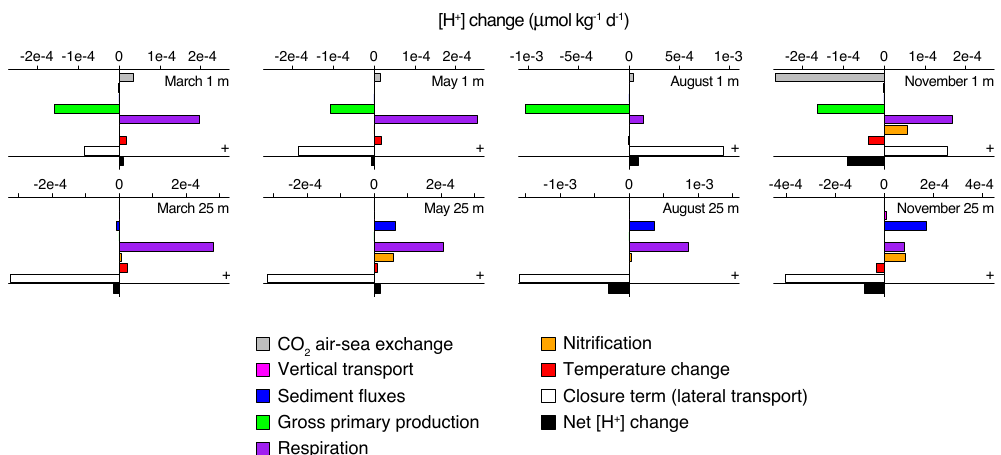
Figure 8. Proton budget for the Den Osse basin at 1 and 25m depth for the months of March, May, August and November. The closure term is calculated as the difference between the calculated and measured net change in [H +